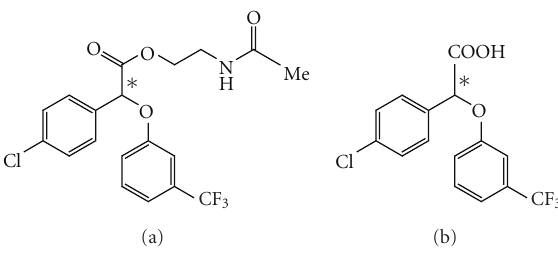
Figure 1: Chemical structures of the prodrug ester (a) and active- free acid form